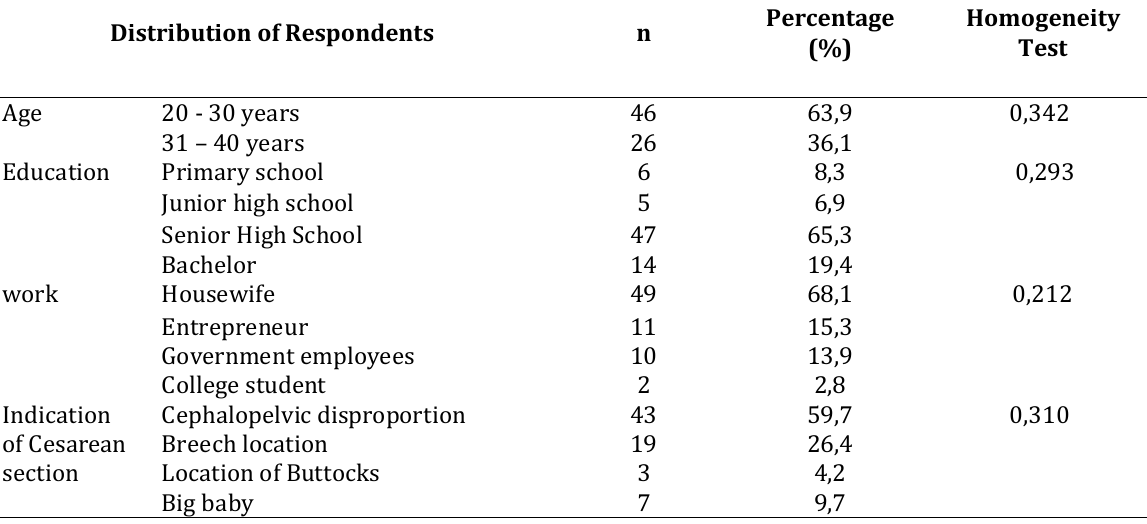
Table 1 Respondents’ Frequency Distribution Based on Age, Education Level, Profession and the Indications of the Post-Caesarean Patients' Sectional Section in Kendari General Hospital